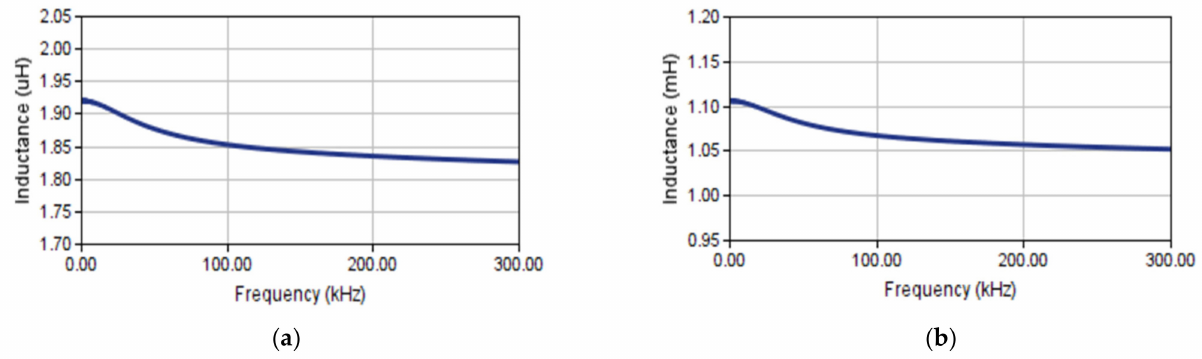
Figure 14. Leakage inductance of toroidal transformer ( N p = 5 & N s = 120). ( a ) Primary winding ( b ) Secondary winding.